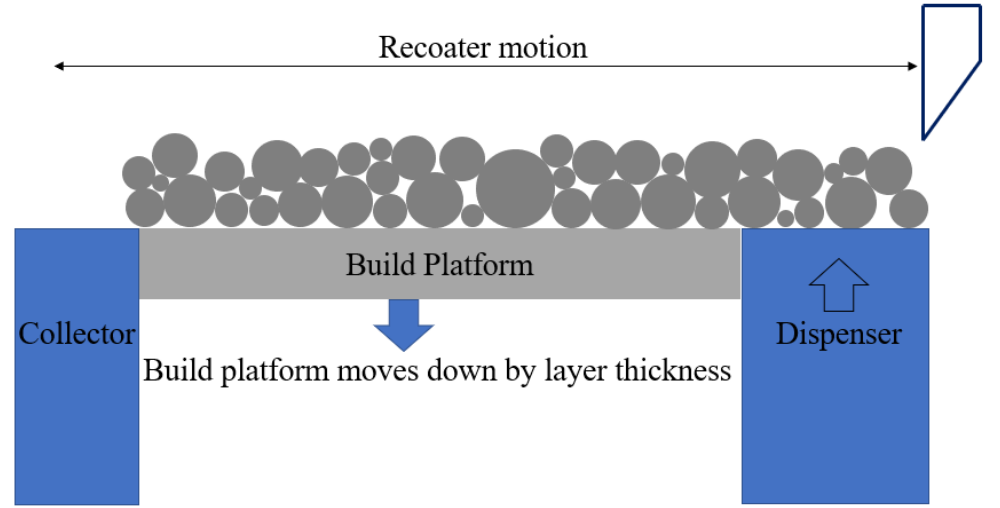
Figure 3. The powder-spreading process during LPBF process. For the DEM simulation of the second layer, the surface formed after scanning the first layer was utilized. The powder bed from the first layer was lowered by 80 µ m, which is the actual thickness of the first layer. However, the gap between the recoater blade and the base was reduced to 40 µ m for the second layer as the shrinkage was accounted for during the first layer scanning simulation. This method enabled the investigation of the variation in the powder distribution and layer thickness across the second layer due to the inherent surface roughness in the first layer. Figure 4 depicts the variation in the gap between the first layer and second layer after the powder-spreading